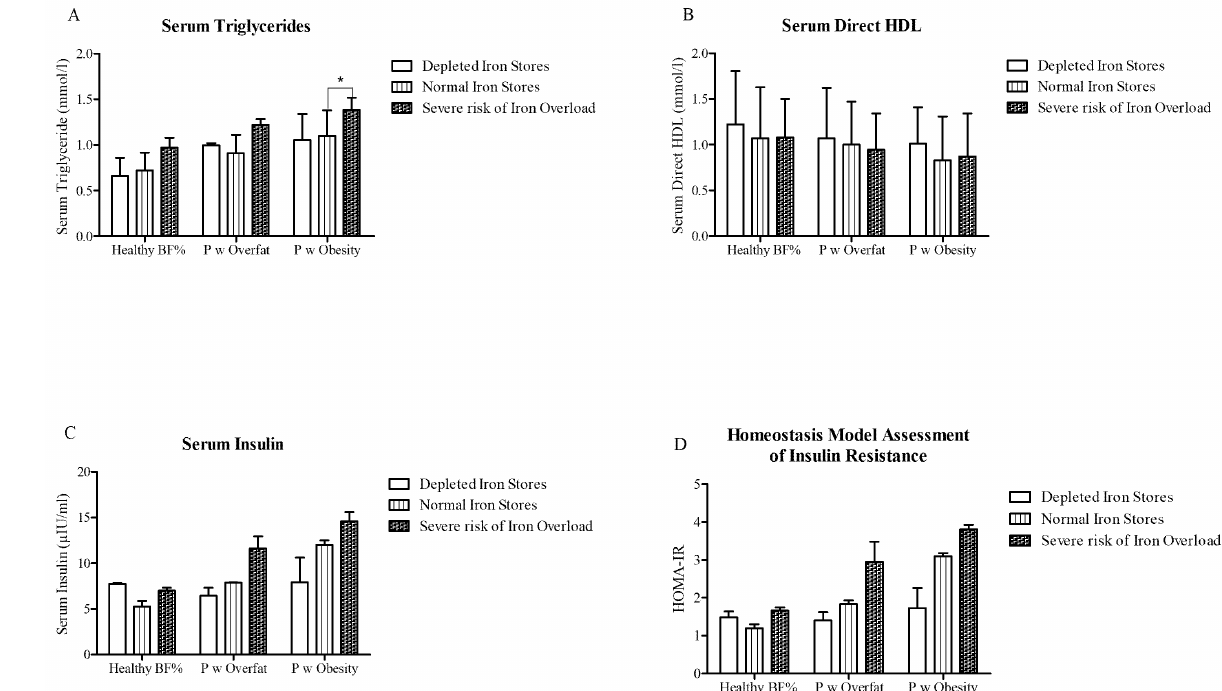
Figure 2. Indices of metabolic health between iron status groups across all categories of BF %: ( A ) serum triglycerides (mmol/L), ( B ) serum direct HDL cholesterol (mmol/L), ( C ) serum insulin ( µ IU/mL), and ( D ) Homeostasis Model Assessment of Insulin Resistance (HOMA-IR).* p < 0.05. ANCOVA of log10-transformed variables (covariates = age, gender, contraception use, and smoking status). Data are presented as the median and IOR. BF % = body fat percentage. P w overfat/obesity = people with overfat/obesity, I-S = iron stores, and I-O = iron overload. Table 5. Risk of metabolic syndrome between iron status groups across categories of % BF. People with Healthy % BF People with Overfat People with Obesity